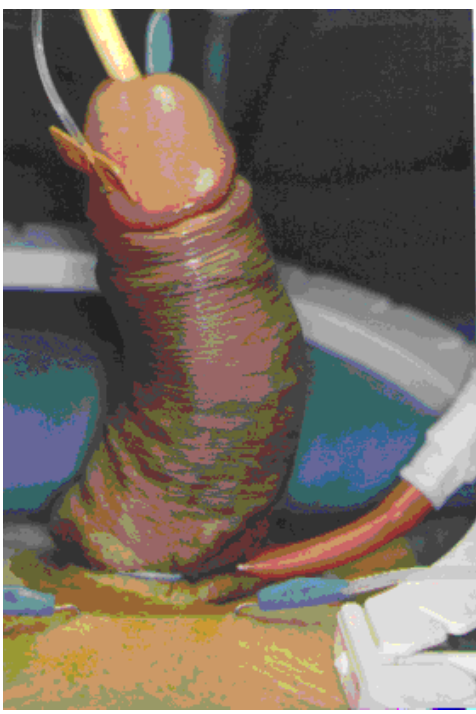
FIGURE 7. Penile curvature due to postoperative fibrosis is present one years after the operation. The patient was operated 48 h. after